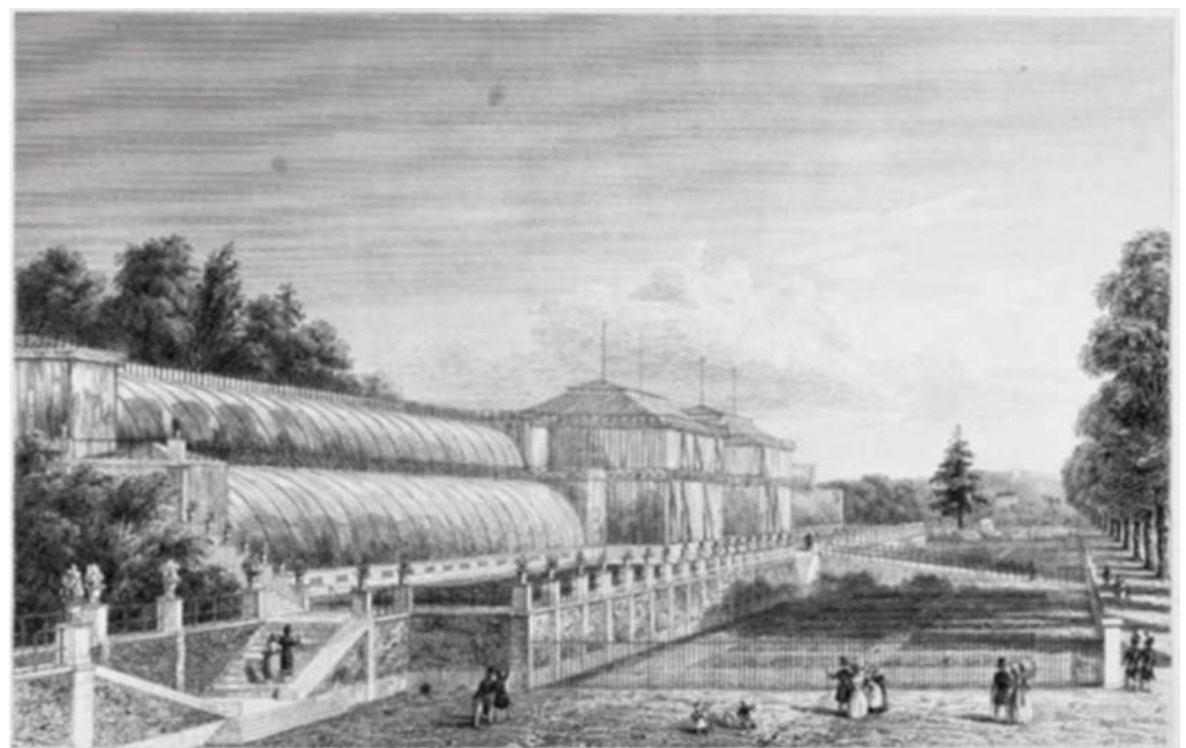
Figure 4. Jardin des Plantes pavilion, iron and glass architecture system for vaulted structures. Fon- taine and Rohault, París, France in 1834 – 1836. Source: Image of the engraving of the greenhouse by an anonymous author. Collection of engravings of the Museum of Natural History of Paris. France.